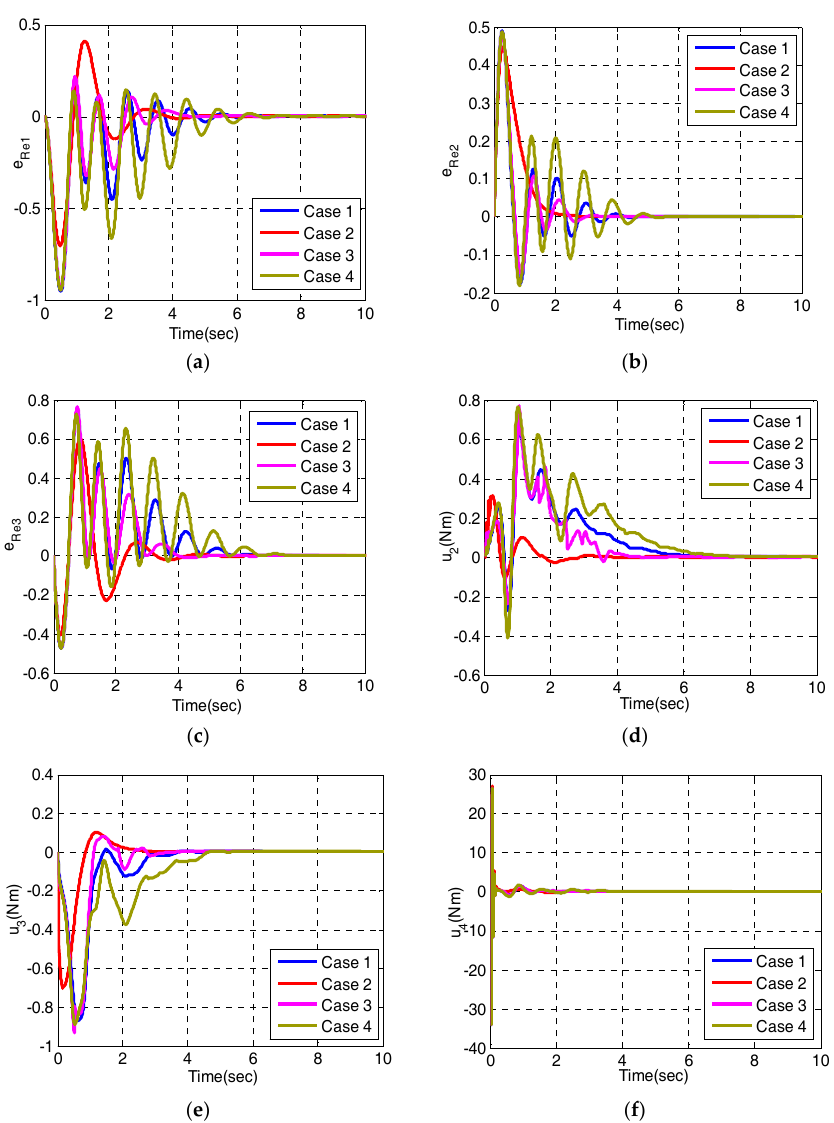
Figure 3. Tracking rotation matrix simulation ( a ) e R ; ( b ) e R ; ( c ) e R ; ( d ) The control input u 2 ; ( e ) The control input u 3 ; ( f ) The control input u 4 . Table 2. The control parameters of the inner loop.